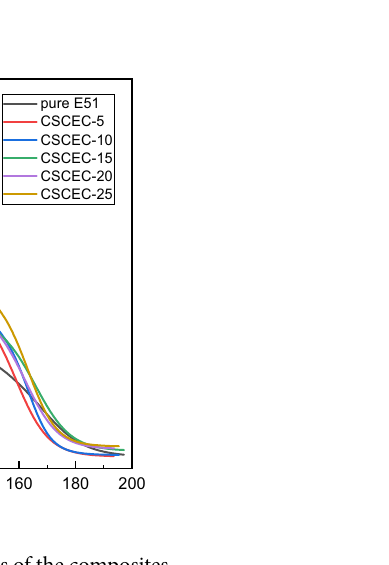
Table 1. Thermogravimetric analysis data of pure E51 and the composites. T 5 is the temperature when the thermal weight loss is 5%; T 10 is the temperature when the thermal weight loss is 10%; Y c is the char yield.